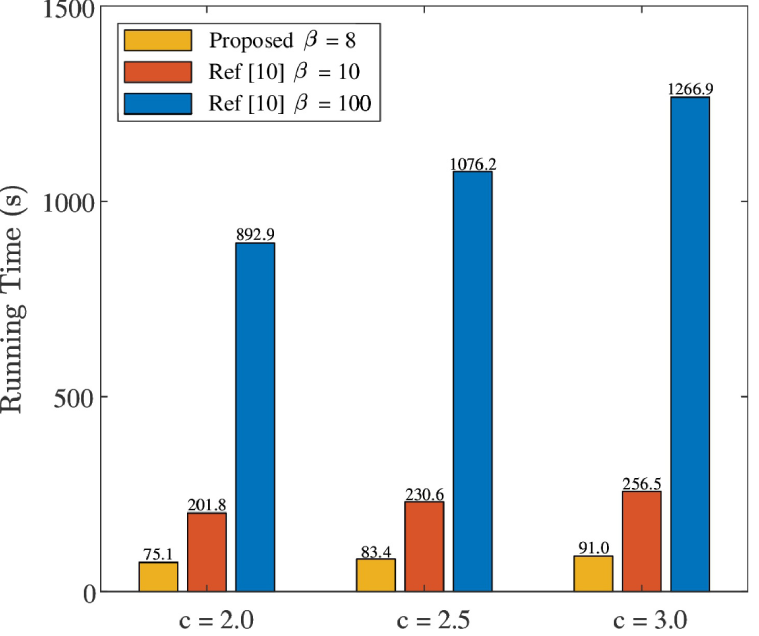
Fig 11. Comparison of “Proposed” and “Ref [10]” about online running time by conducting 10 5 times of experiments, where P = 512 and ρ = 0.10 are considered.